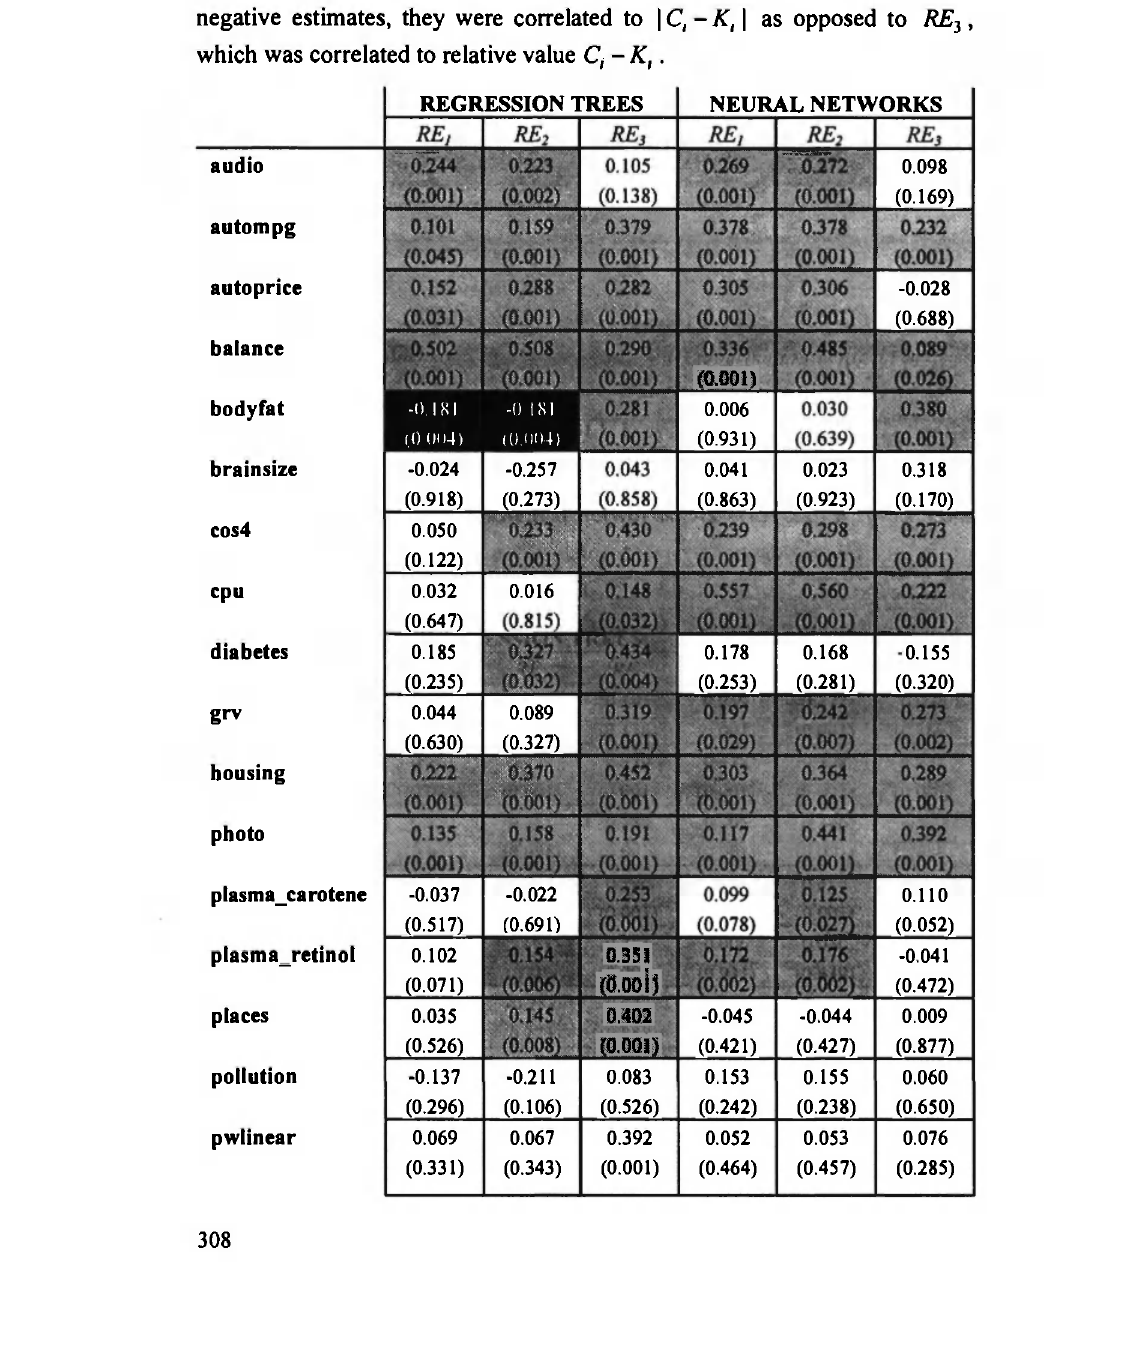
Correlation coefficients of the reliability estimates and the prediction error for the regression trees and the neural networks. As R£\ and RE 2 are non- negative estimates, they were correlated to | C, - Κ, | as opposed to RE 3 , which was correlated to relative value C t -